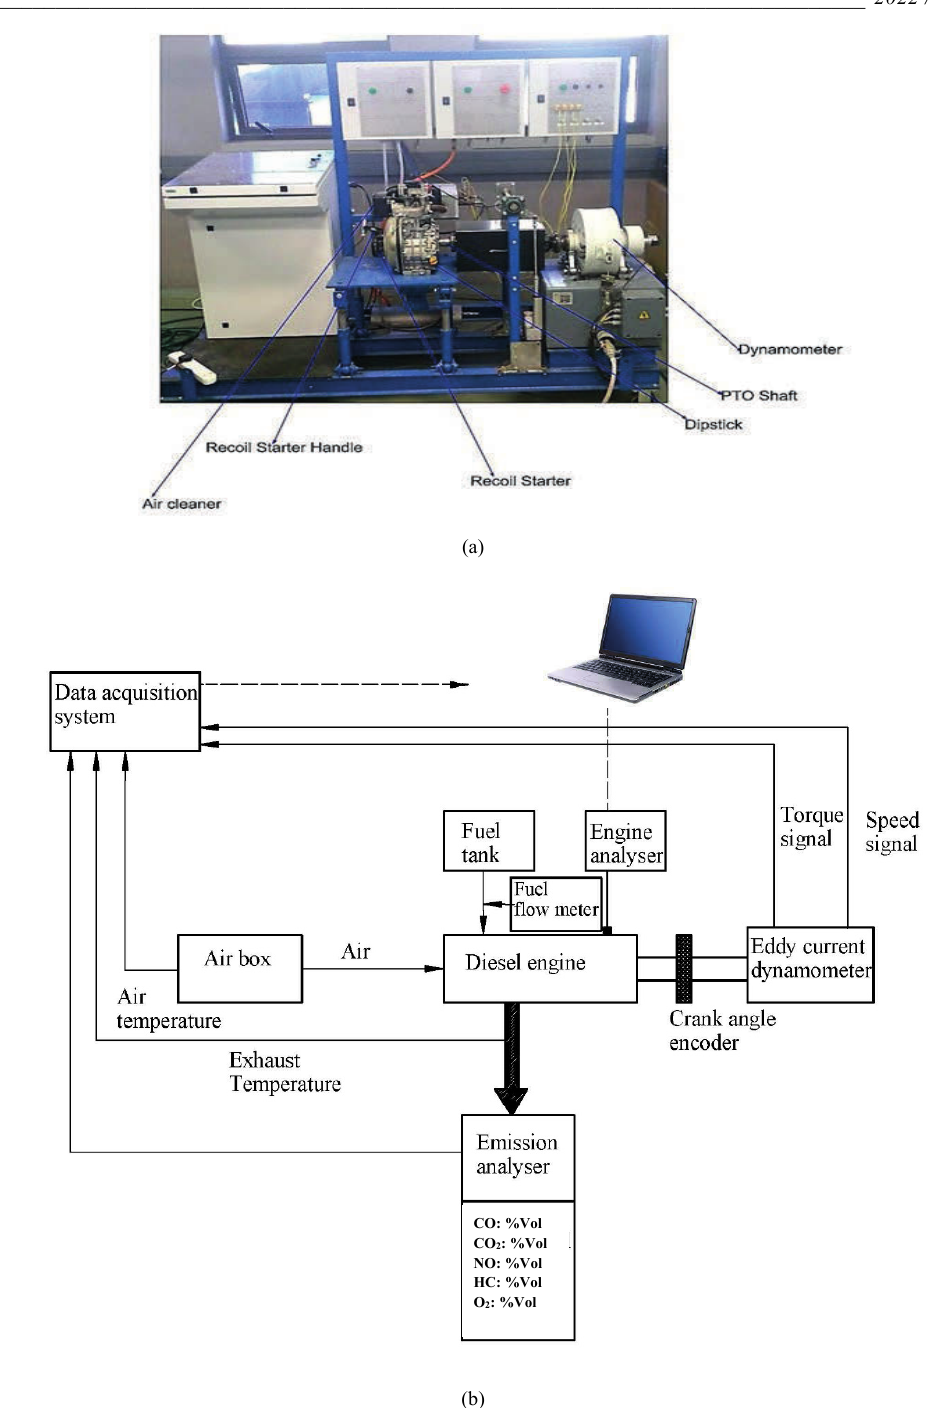
Fig. 1. Engine test setup: a) photographic; b)